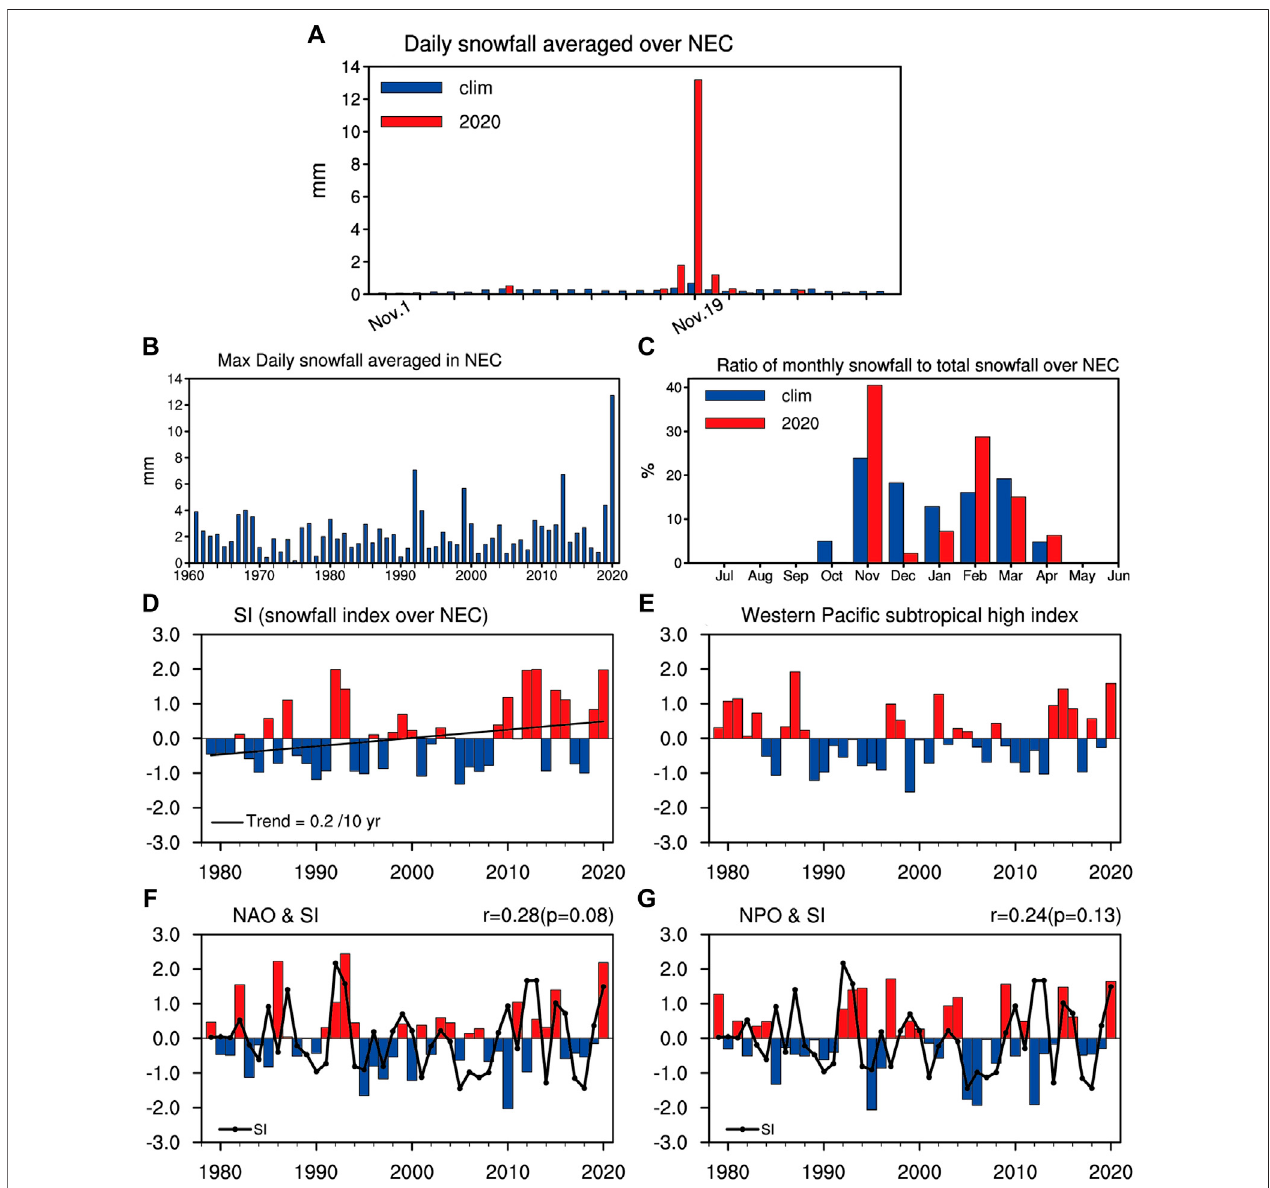
FIGURE 2 | (A) Time series of mean daily snowfall in Northeast China in November 2020 and its corresponding climatology. (B) the maximus daily snowfall in November during 1961 – 2020. (C) Average ratios of monthly snowfall to total snowfall in Northeast China for each month. (D-G) Normalized time series of (D) mean snowfallindexaveragedinNortheastChina, (E) westernPaci fi csubtropicalhigh(WPSH)index, (F) NorthAtlanticOscillation(NAO)index,and (G) NorthPaci fi cOscillation (NPO) index during November 1970 – 2020. The black line in (D) represents the linear line. The black line in (F,G) represents the snowfall index averaged over Northeast